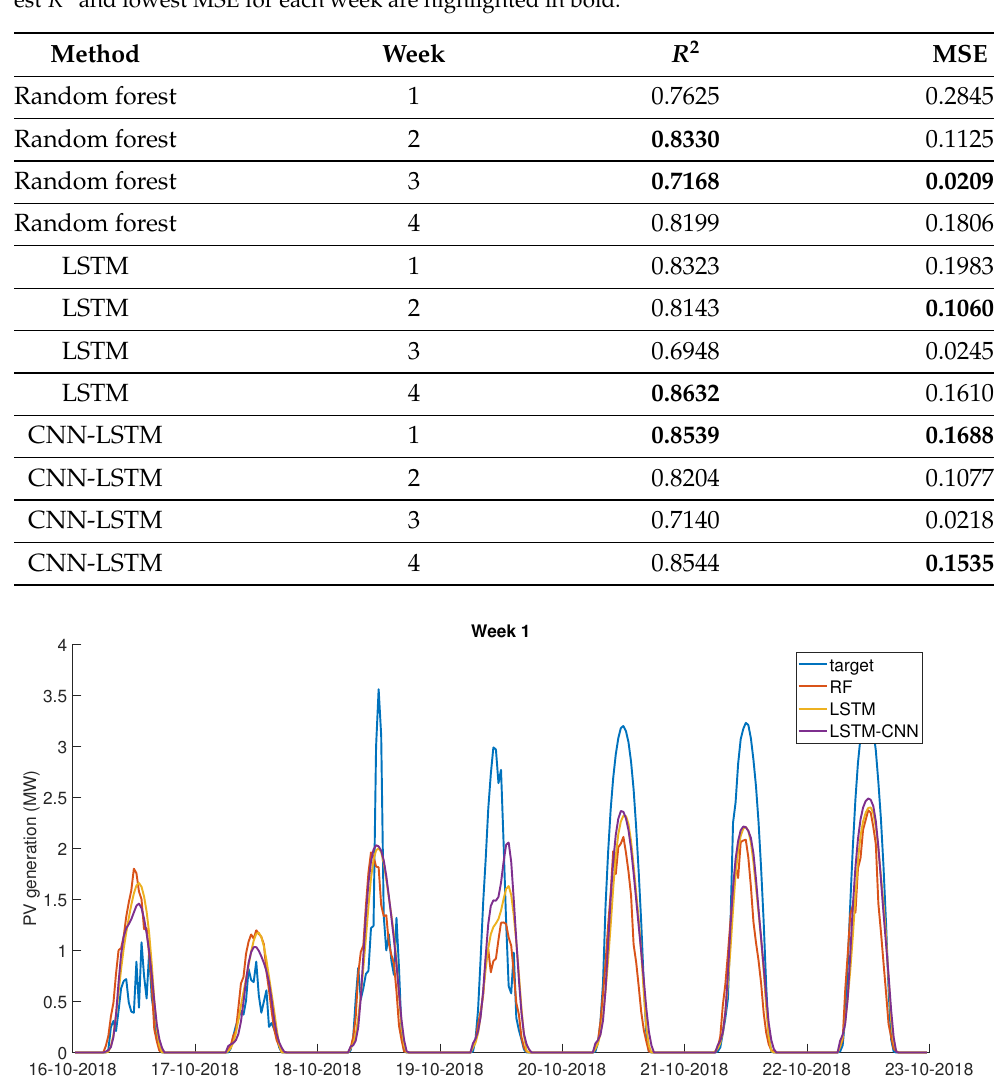
Figure 5. Plots of model predictions for week 1 showing a comparison of the three proposed models with the